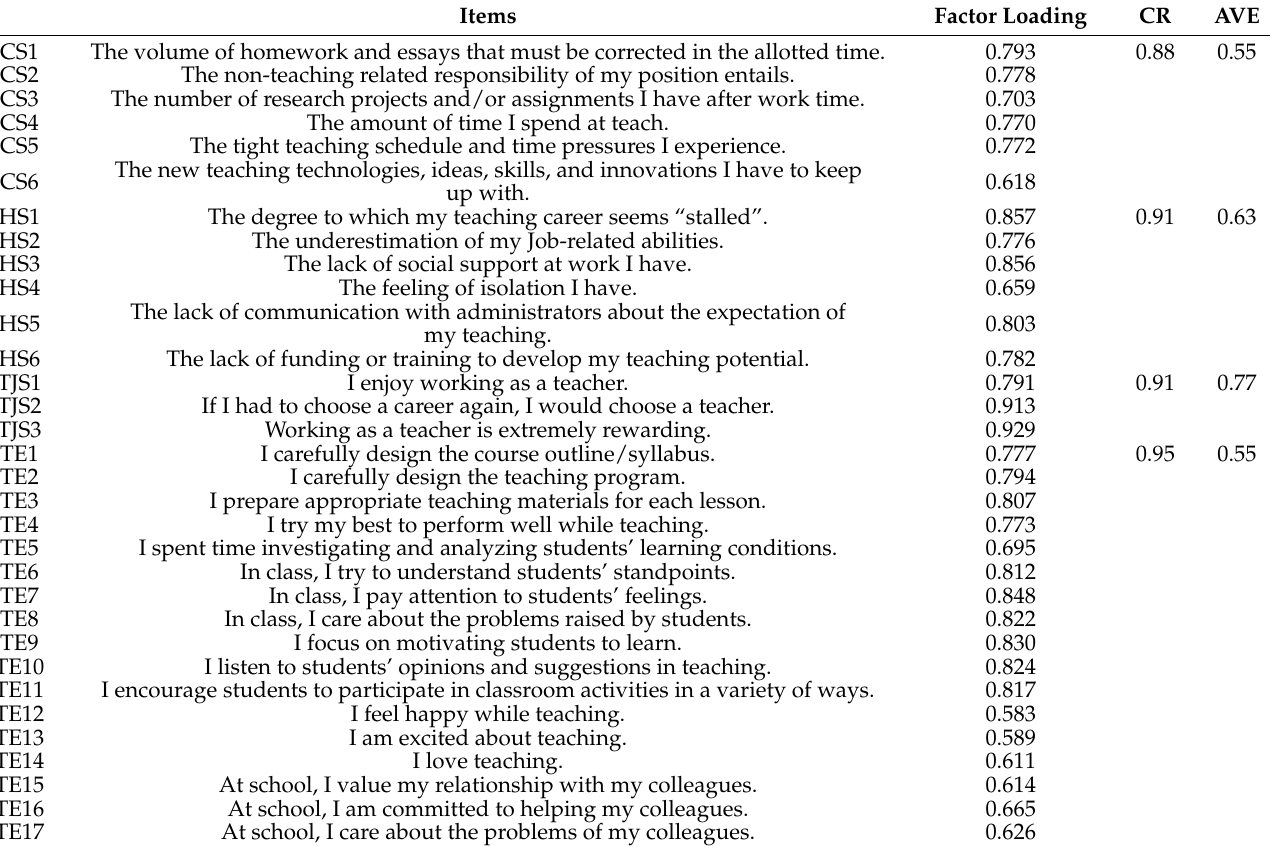
Table 1. Results of the measurement model assessing construct reliability (N = 7743). Items Factor Loading CR